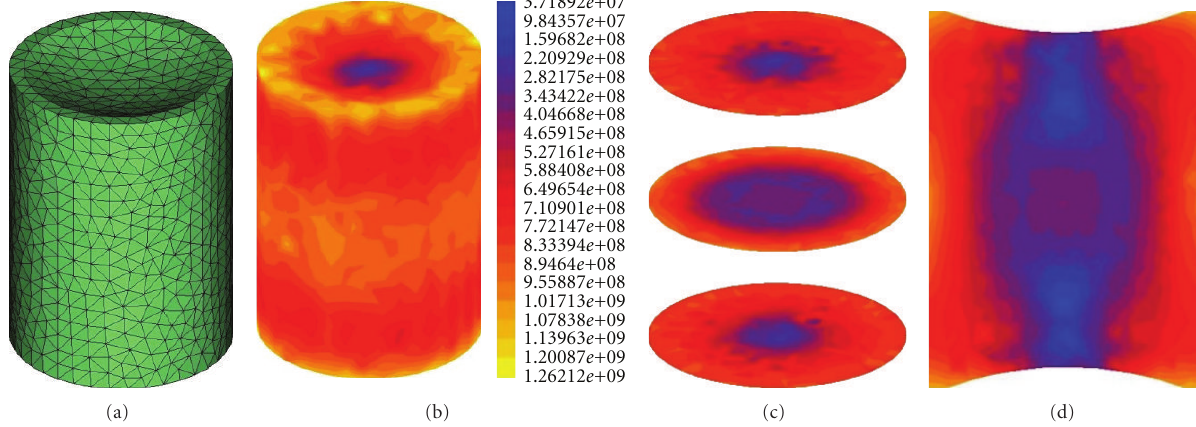
Figure 3: Mesh and von Mises equivalent stress of the pellet. (a) Unstructured mesh for finite elements calculation. (b) 3D view of the von Mises equivalent stresses. (c) Three horizontal sections of the von Mises stress field. (d) Vertical section through the symmetry axis of the von Mises stress field.